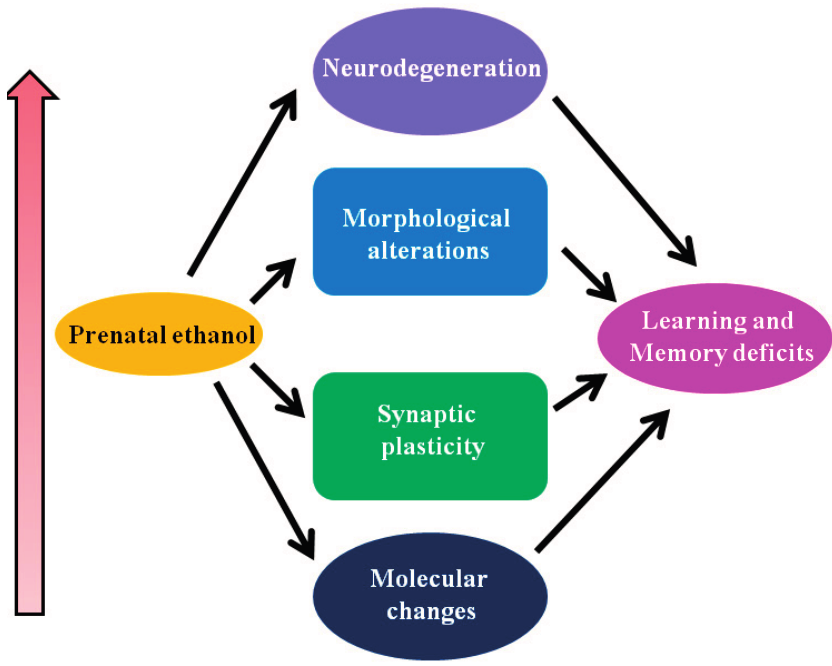
Figure 3. Molecular events leading to loss of learning and memory as found in